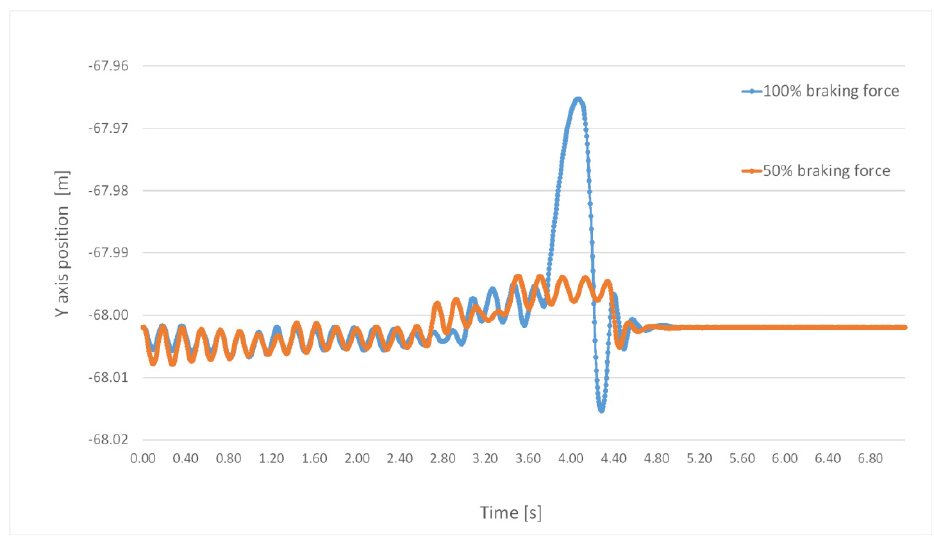
Figure 13. Displacement of the rail No. 5 along the Y axis, during braking from speed 5 m/s. Figure 14 shows the displacement of the rail No. 5 in the vertical axis ( Z axis). The maximum rail displacement in this axis was 0.0193 m when using the full braking force, while when using the braking force reduced by half, the displacement was 0.0024 m.